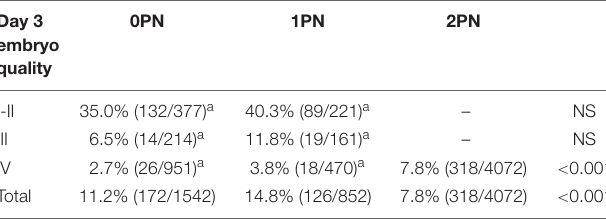
TABLE 2 | Good-quality blastocyst rate of abnormal fertilized (0PN and 1PN) and poor-quality day 3 embryos (2PN).